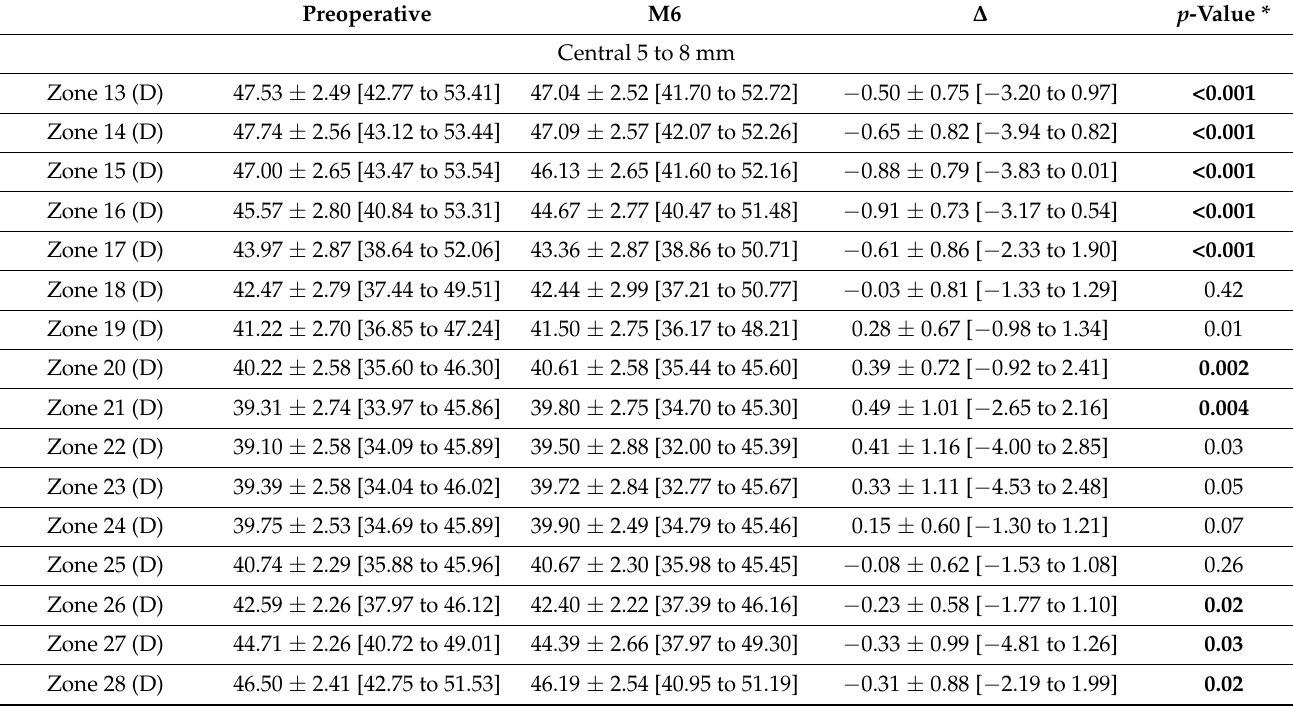
* Wilcoxon signed-rank test. All values are presented as the mean ± standard deviation and [range]. Significant results are indicated in bold.